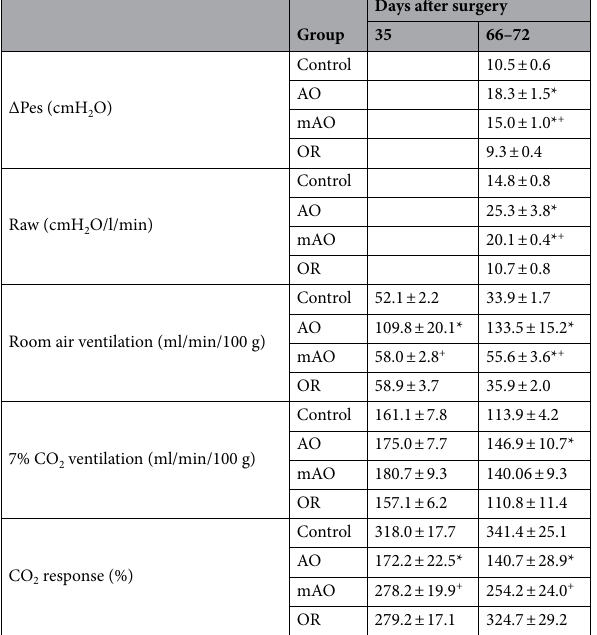
Table 1. Respiratory data. Values are mean ± SEM. For ∆Pes, Raw and CO 2 response statistical differences were determined by a one-way analysis of variance. For room air ventilation and CO 2 ventilation, statistical differences were determined by a two-way ANOVA followed by a post-hoc Student–Newman–Keuls test. ∆Pes inspiratory swings in esophageal pressure, raw airway resistance, AO obstructive, mAO mild obstruction, OR obstruction removal. * p < 0.01—C vs. AO, mAO or. + p < 0.05, mAO vs.